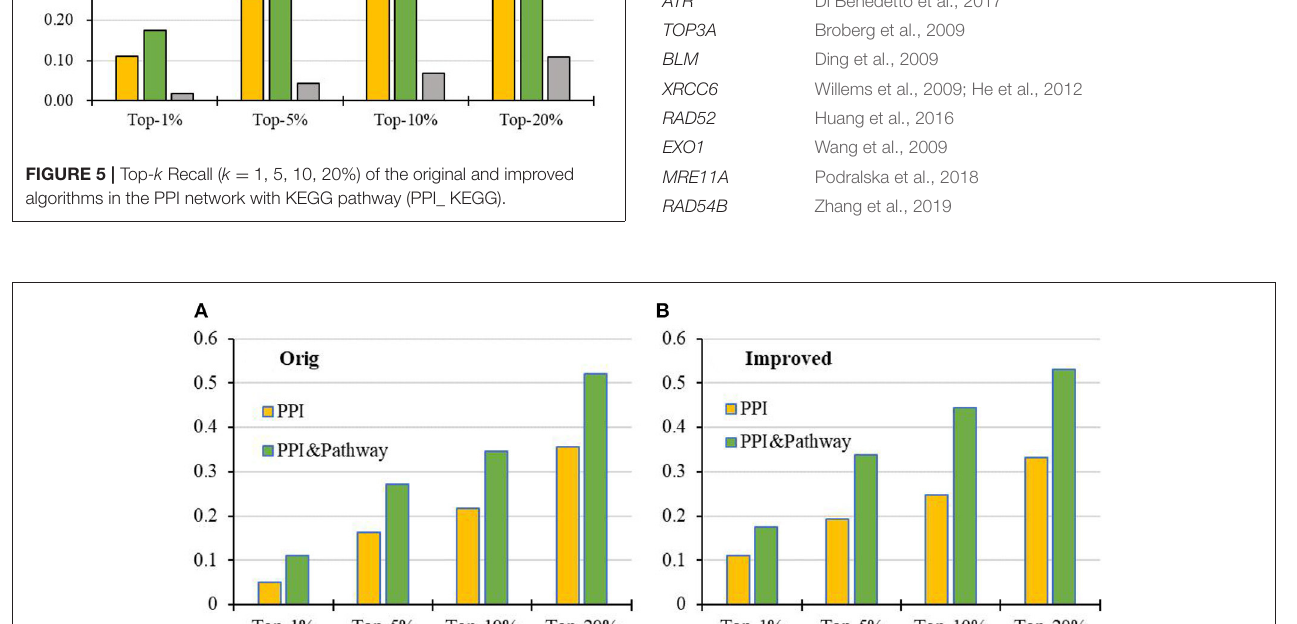
1, 5, 10, 20%) in the PPI network with and without KEGG pathway by the (A) original algorithm and (B) improved =